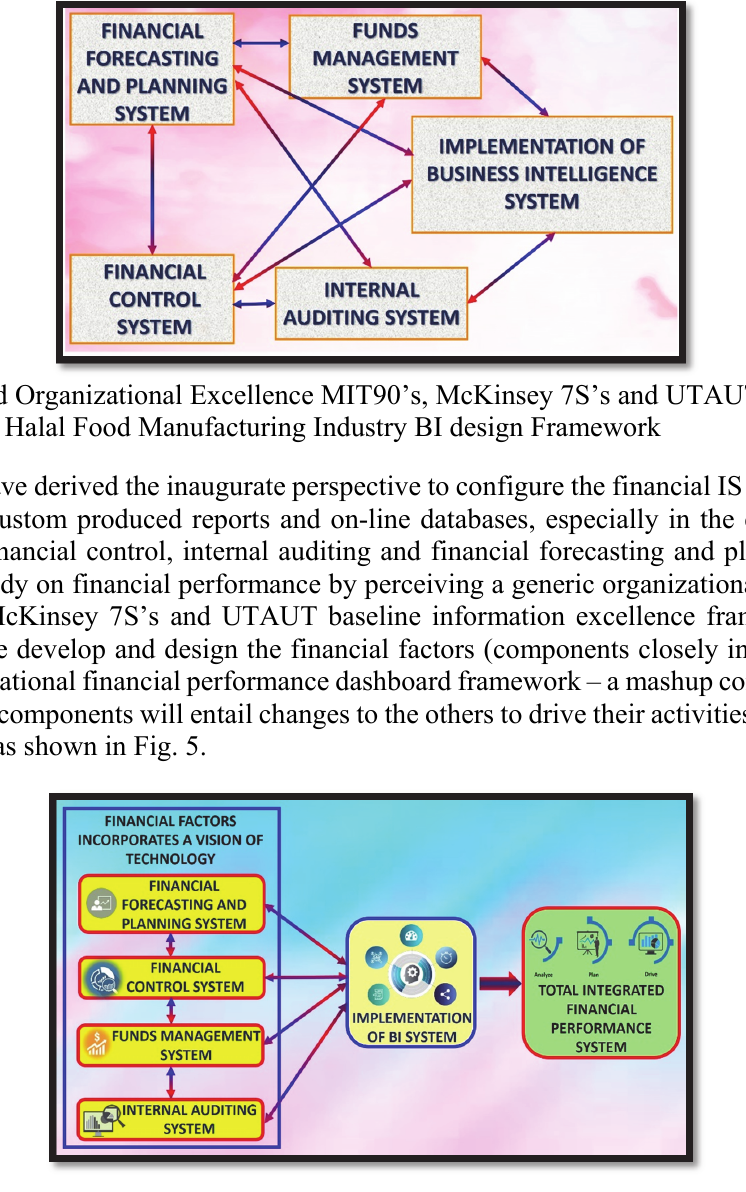
Fig. 5. The Finalized Perspective of an Organizational MIT90’s, McKinsey 7S’s and UTAUT -